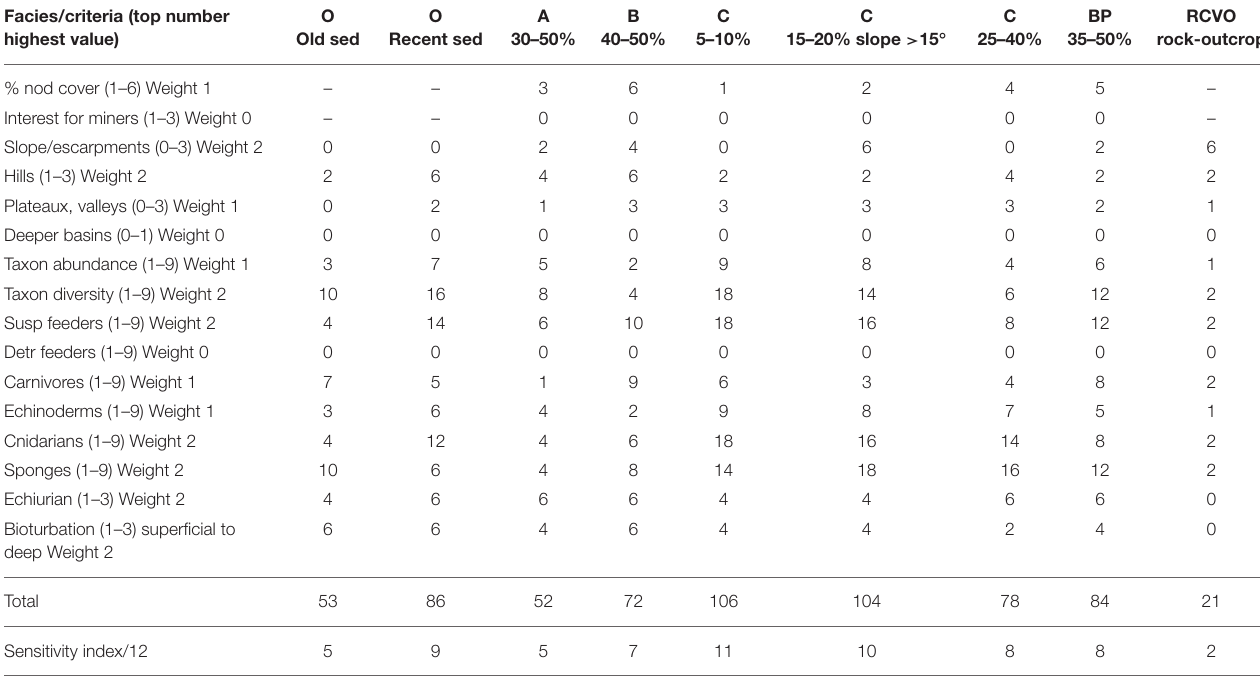
TABLE 3B | “Sensitivity Index” values for NIXO 45 based on results of UNESCO/COI baseline survey (Tilot, 2006a). Facies/criteria (top number highest